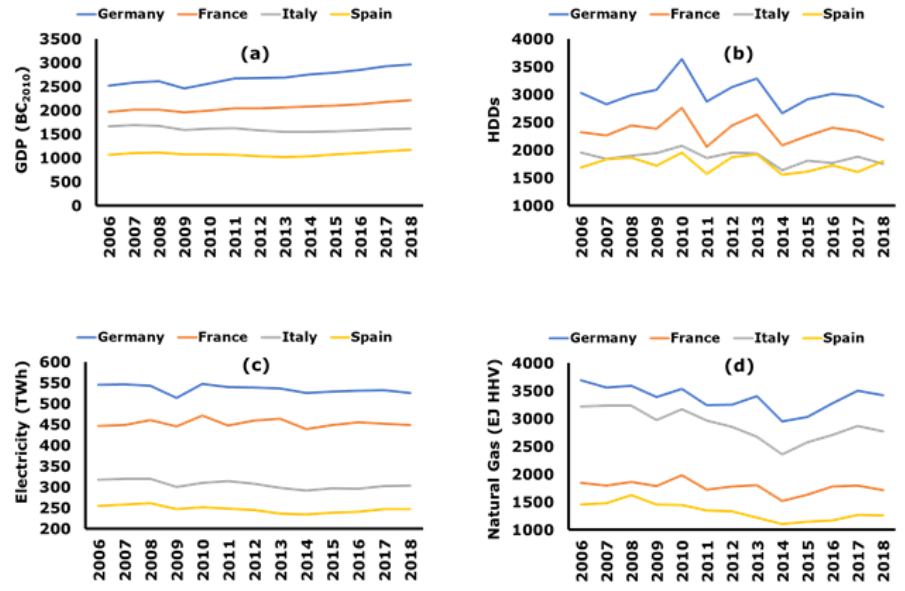
Figure 1. Trend of energy consumption and relevant explaining variables: ( a ) GDP, ( b ) HDDs, ( c ) electricity, and ( d ) natural gas. Source: